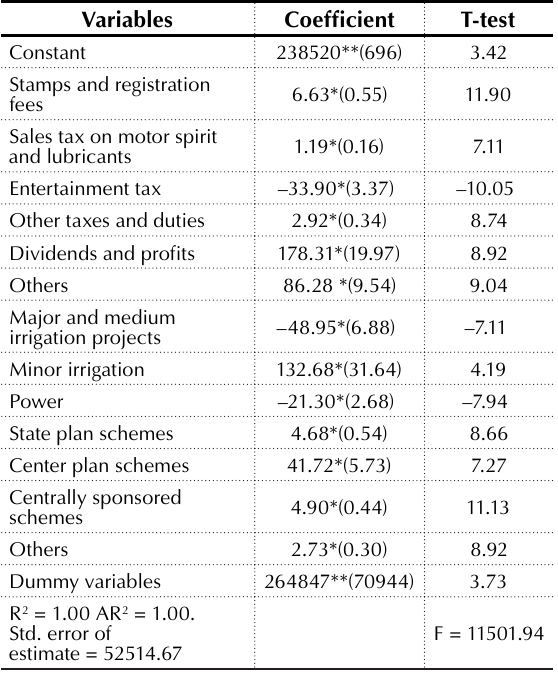
Table 9. Regression results for revenue